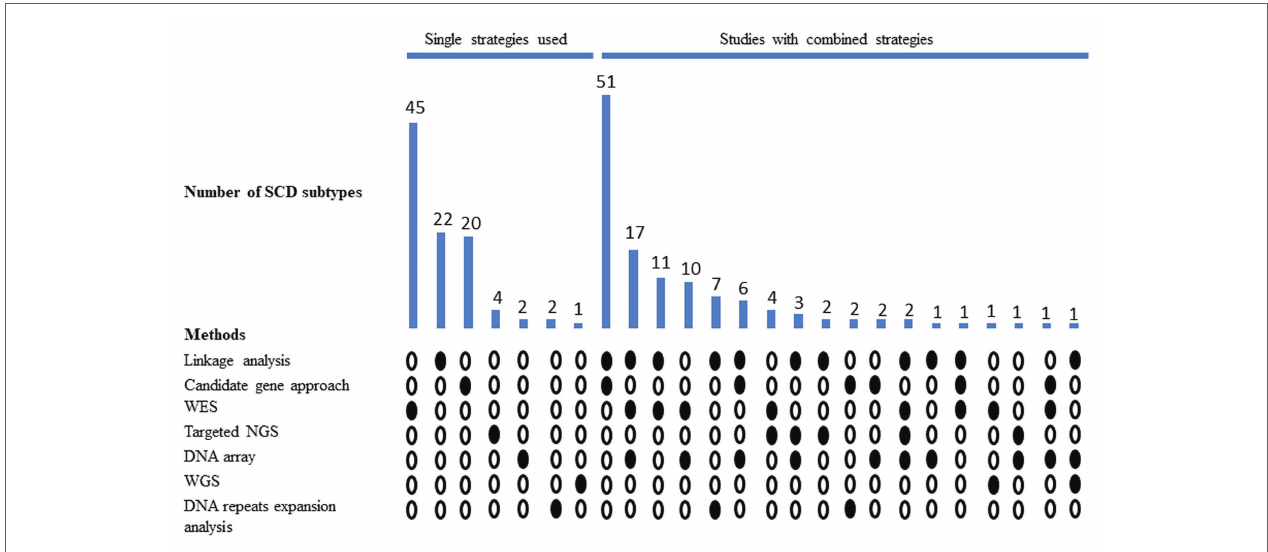
FIGURE 1 | Methods used in diagnosing novel subtypes of hereditary spinocerebellar degeneration (SCD). Filled circles represent the methods used in identifying SCD subtypes, and the bar chart shows the number of SCD subtypes identified by each method or combination of methods. Empty circles represent the unused methods. SCD, hereditary spinocerebellar degeneration; WES, whole-exome sequencing; NGS, next-generation sequencing; and WGS, whole-genome